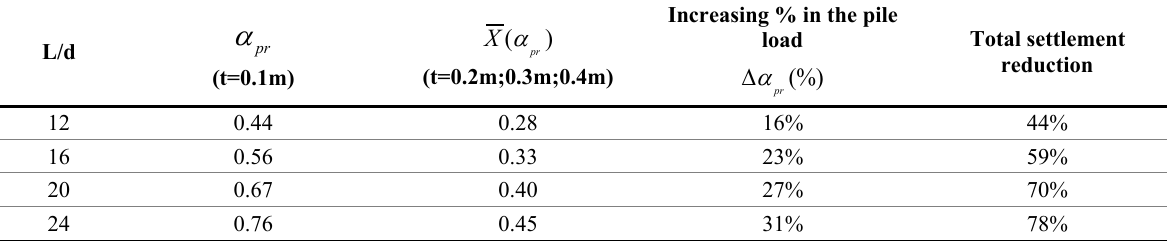
Table 3. Results from the evaluation of the piled raft